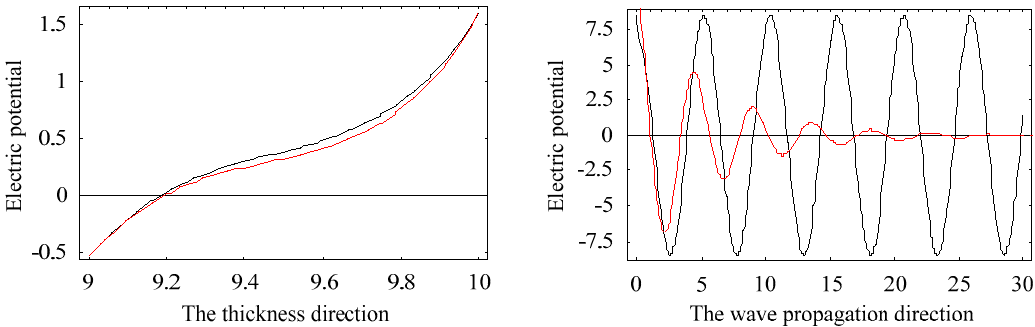
Figure 15. Distributions of the electric potential: black lines for Ω = 1.21815, Ψ = 0.19264, red lines for Ω = 1.21019, Ψ = 0.21937–0.02803i.